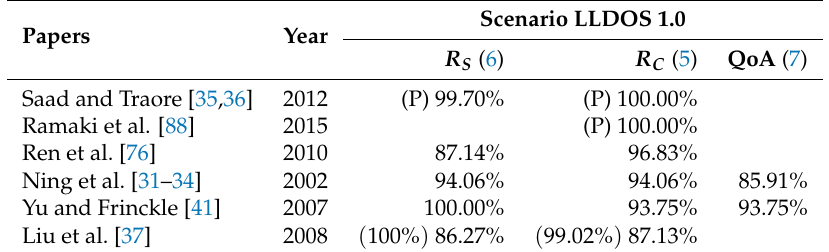
Table 4. Selected success metrics calculated on the basis of results on the DARPA 2000 dataset.